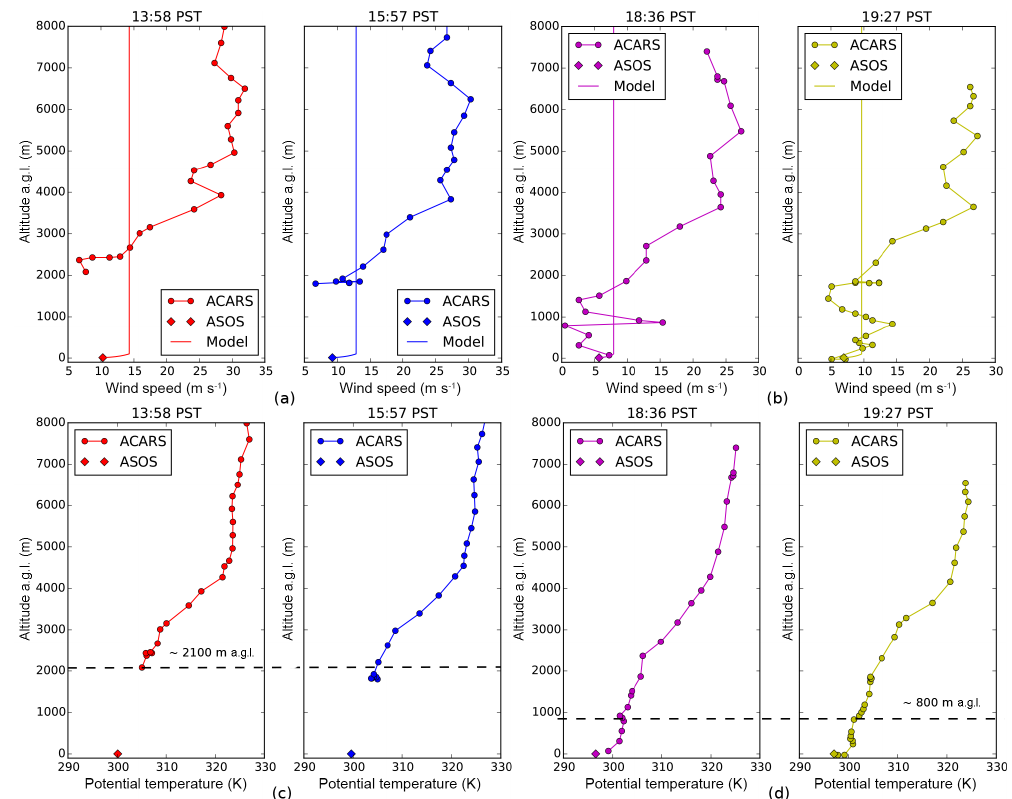
Figure E1. Vertical profile of the horizontal wind speed measurements and the calculated potential temperature profiles, at Ontario airport during (13:58 and 15:57PST) and after the FTS measurements (18:36 and 19:27PST), on 24 January 2015.